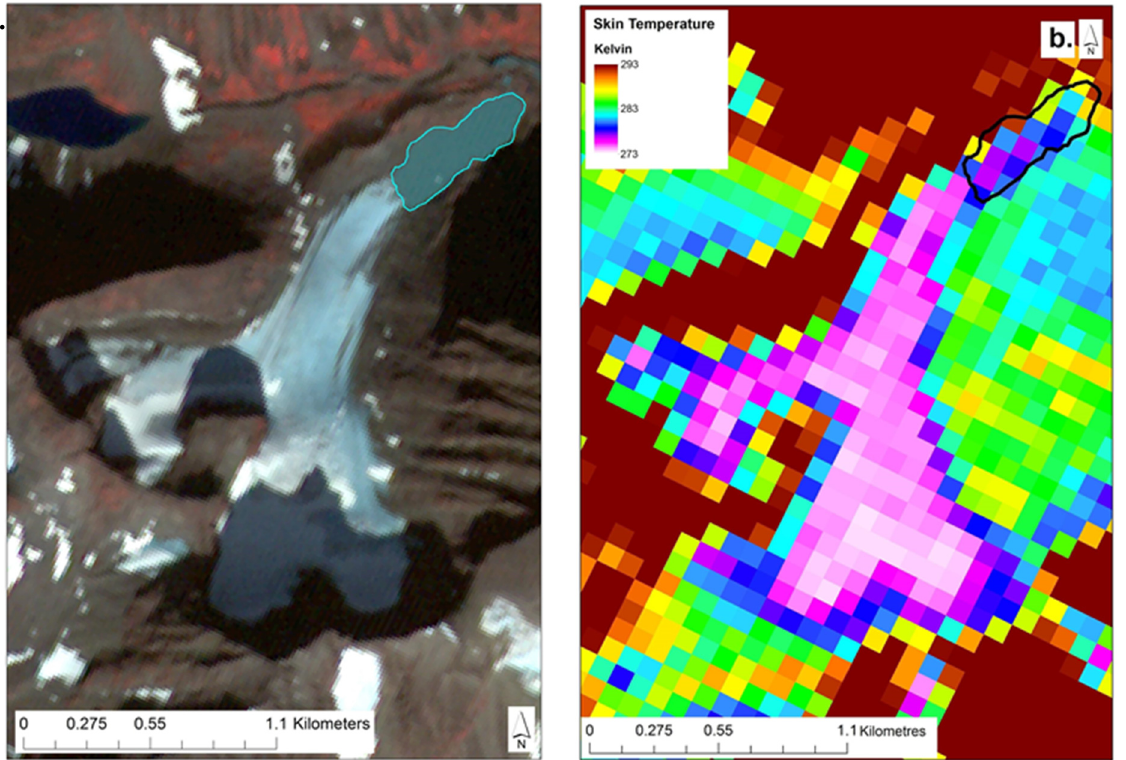
Figure 8. Proglacial lake 6 and Kaskapakte Glacier; ( a ) ASTER satellite composite image (green, red, NIR) and ( b ) ASTER surface temperature product image (AST08) at 10:46 a.m. on 8 August 2014.